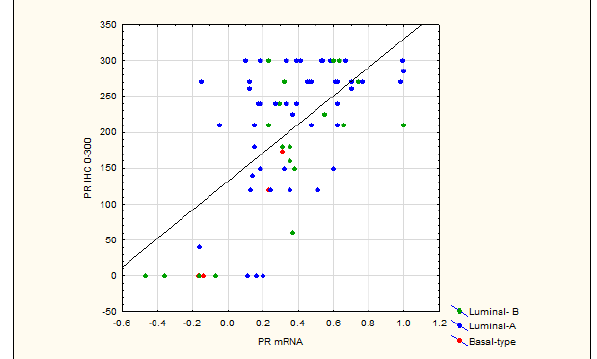
Scatterplot showing the relationship between progesterone receptor (PR) immunohistochemistry (IHC) score and mRNA score; Spearman R =0.54 ( p =0.00).